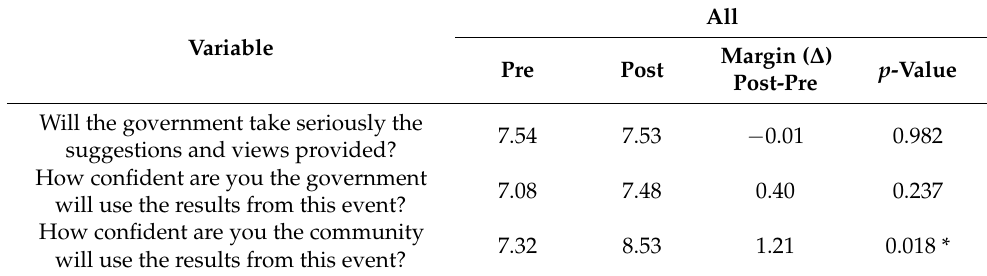
Table 6. Comparing pre- and post means of the study participants on three variables measuring participants’ expression of trust in the government and community using results from the DP. All Variable Margin ( ∆ ) p -Value Pre Post Post-Pre 7.54 7.53 − 0.01 0.982 7.08 7.48 0.40 0.237 7.32 8.53 1.21 0.018